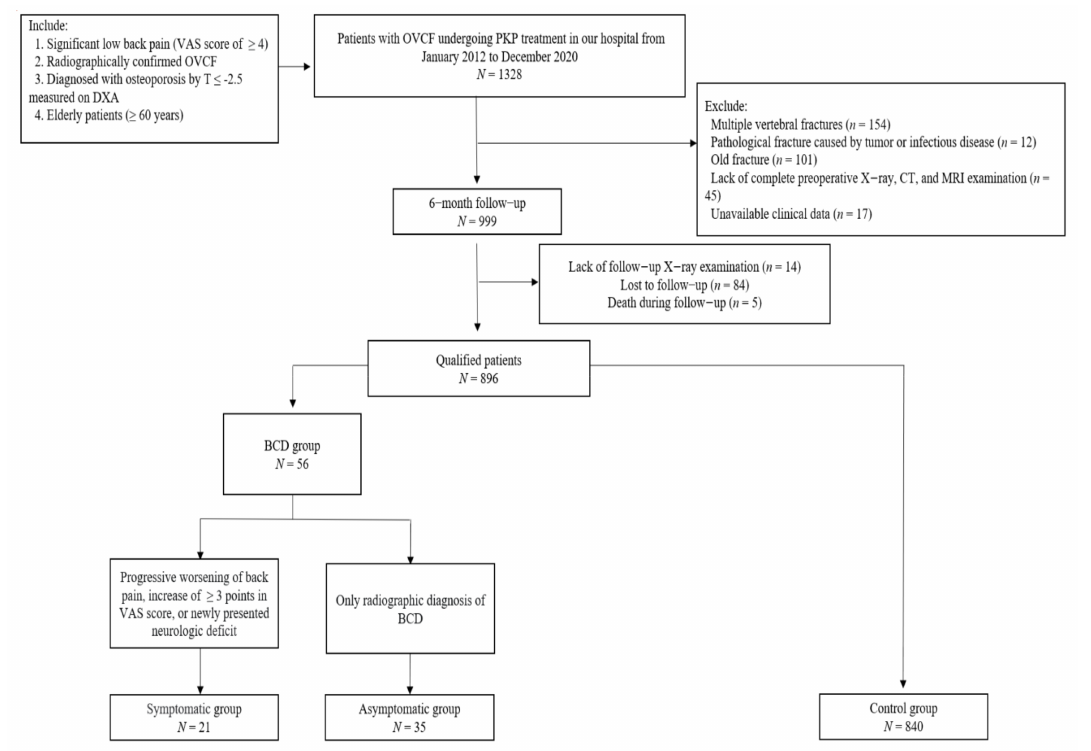
Figure 1. The flowchart of the study. OVCF = osteoporotic vertebral compression fracture, PKP = percutaneous kyphoplasty, DXA = dual-energy X-ray absorptiometry, CT = computed to- mography, MRI = magnetic resonance imaging, BCD = bone cement displacement, and VAS = Visual Analogue Scale.